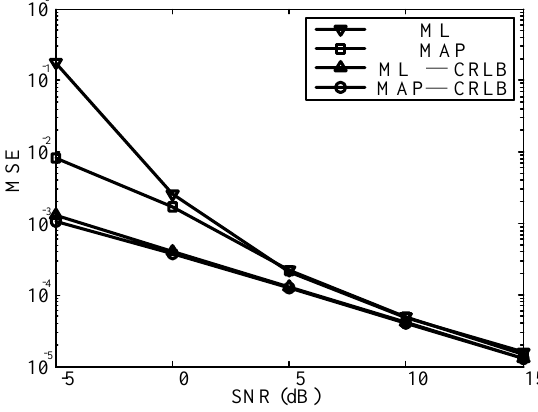
Fig.4.Performance comparison between MAP and ML in 4 1 ×